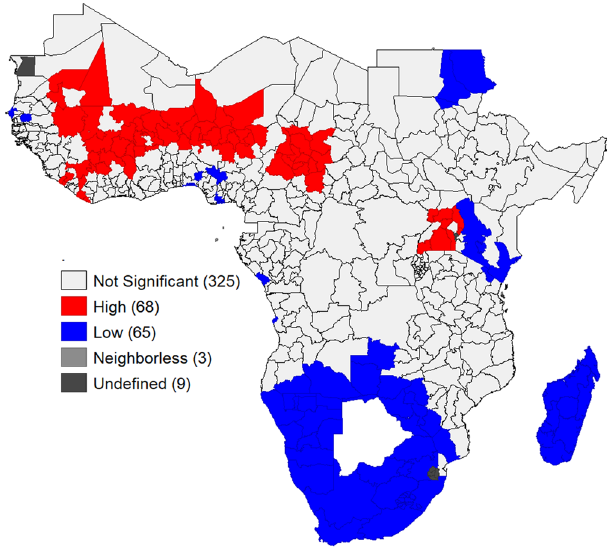
Figure 5. Hot-spots and cold-spots of women who suffer child death: each polygon on the map represents a single zone area with mothers who suffer child death. High (red colour) means high (hot spot) of mothers who suffer from child death. Low (blue colour) shows a low (cold spot) of mothers who lost at least one child. To perform this analysis was used GeoDa GIS version